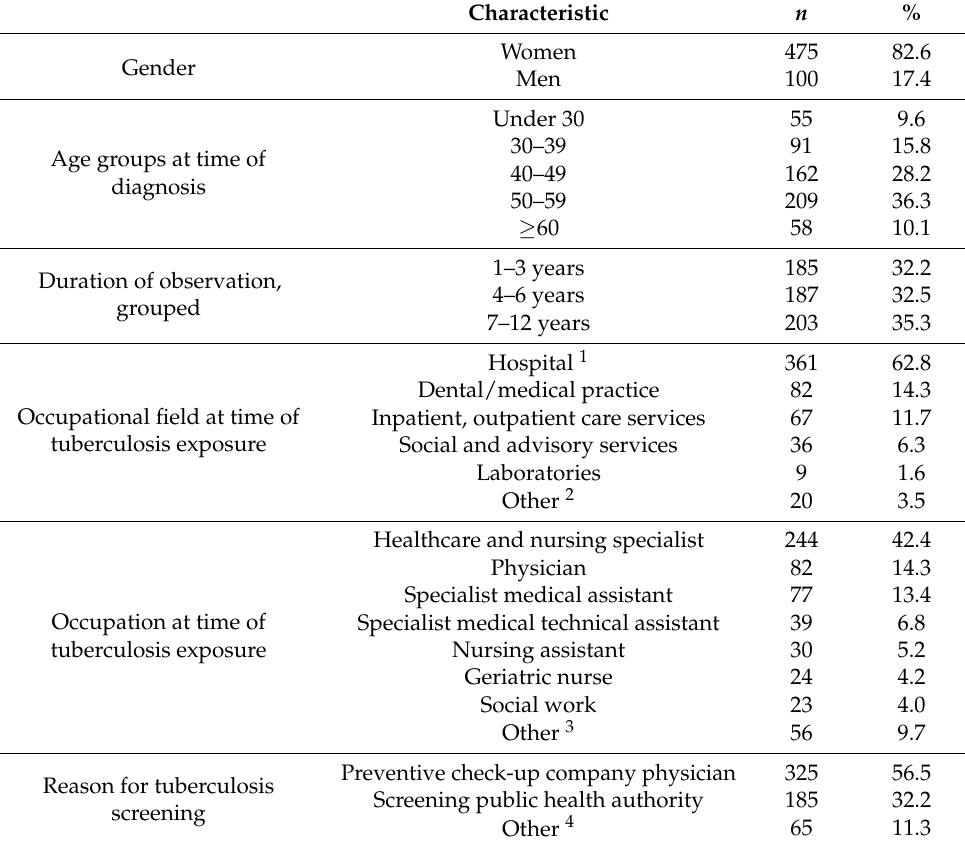
Table 2. Description of the study population from the survey ( n =